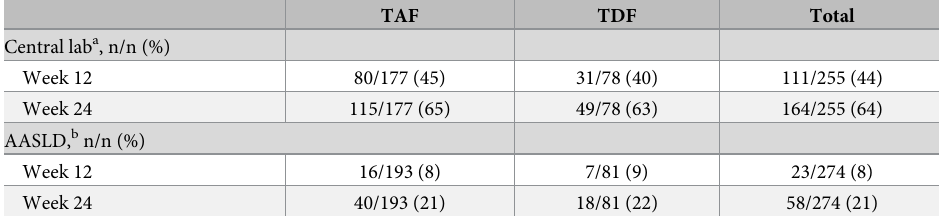
Four patients in the TAF group (2%) experienced 1 serious adverse event each of anemia, appendicitis, pneumonia, and pyrexia; none of these events was treatment-related or required treatment interruption or discontinuation. The most commonly reported Grade 3 laboratory abnormalities included blood in the urine and elevations in serum ALT ( Table 4 ). Table 4. Adverse events through 24 weeks in the subset of WOCBP (studies GS-US-320-0110 and GS-US-320- 0108; week 96 integrated safety analysis set; reference 21). TAF (n = 194) TDF (n = 81) Any adverse event 138 (71) 55 (68) Any study drug − related adverse event 38 (20) 17 (21) Any Grade 3 or 4 adverse event a 3 (2) 1 (1) Any serious adverse event a 4 (2) 0 Any serious adverse event related to study treatment 0 0 Any adverse event leading to discontinuation of study treatment 0 0 Deaths, n 0 0 Common AEs ( � 6% in either group) Nasopharyngitis 24 (12) 4 (5) Headache 16 (8) 7 (9) Upper respiratory tract infection 13 (7) 4 (5) Cough 12 (6) 3 (4) Nausea 12 (6) 6 (7) Abdominal pain (upper) 11 (6) 2 (2) Dyspepsia 8 (4) 5 (6) Lab Abnormalities ( � 2% in either group) Occult Blood, Grade 3 35 (18) 16 (20) Urine Erythrocytes, Grade 3 28 (14) 19 (23) Alanine Aminotransferase, > 5 × ULN 18 (9) 7 (9) Aspartate Aminotransferase, > 5 × ULN 5 (3) 6 (7) Creatine Kinase, � 10 × ULN 5 (3) 0 Urine Glucose, Grade 3 3 (2) 0 Hemoglobin, 7 to < 9 g/dL 3 (2) 2 (3) Data are presented as n patients (%). AE , adverse event; TAF , tenofovir alafenamide; TDF , tenofovir disoproxil fumarate. a No reported Grade 3 or 4, or serious AEs were considered to be related to study drug.